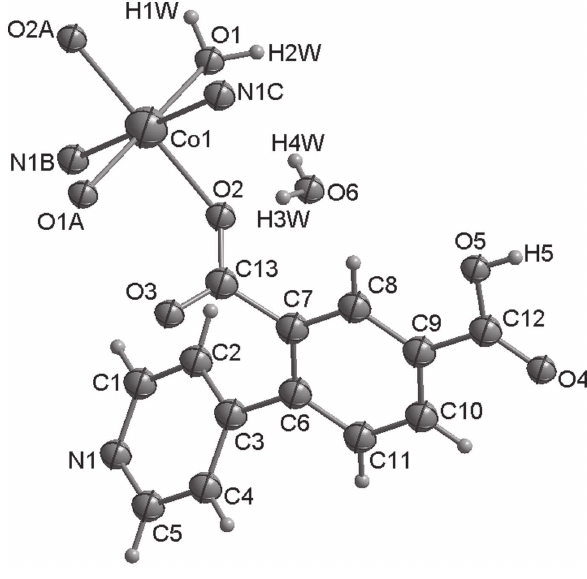
Table 1: Data collection and handling.